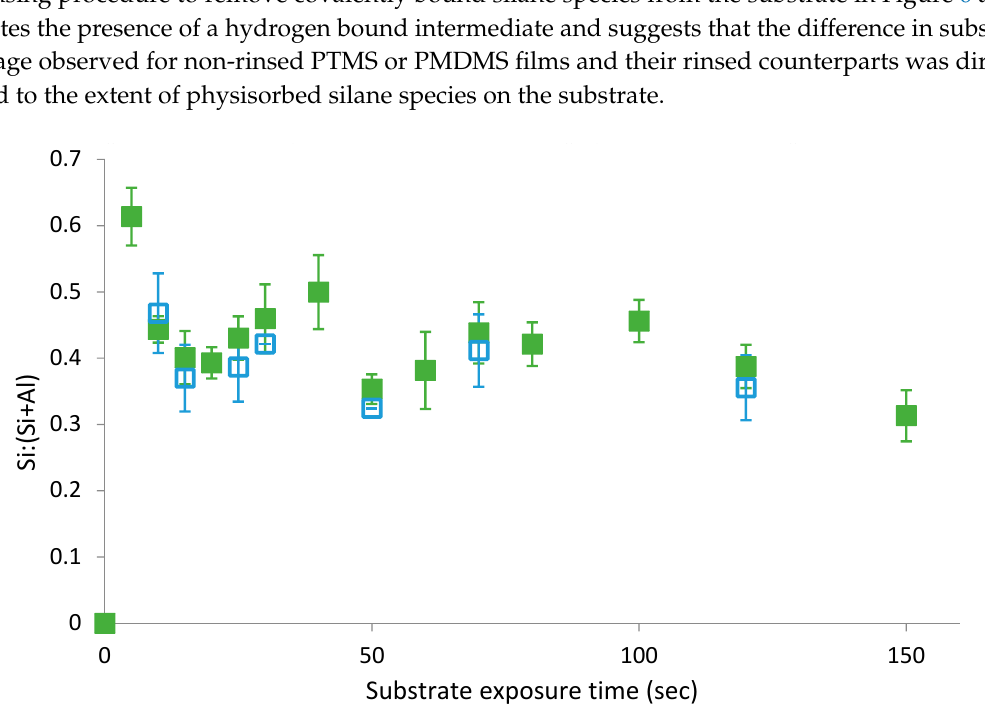
Figure 5. Oscillatory adsorption of 1% PTMS in 1:1 EtOH:H 2 O solvent at pH3 on aluminium foil substrate measured using XPS. Upon removal from solution, films were either dried with N 2 (solid green squares) [8] or rinsed with pH3 CH 3 COOH (open purple squares) prior to drying and curing.